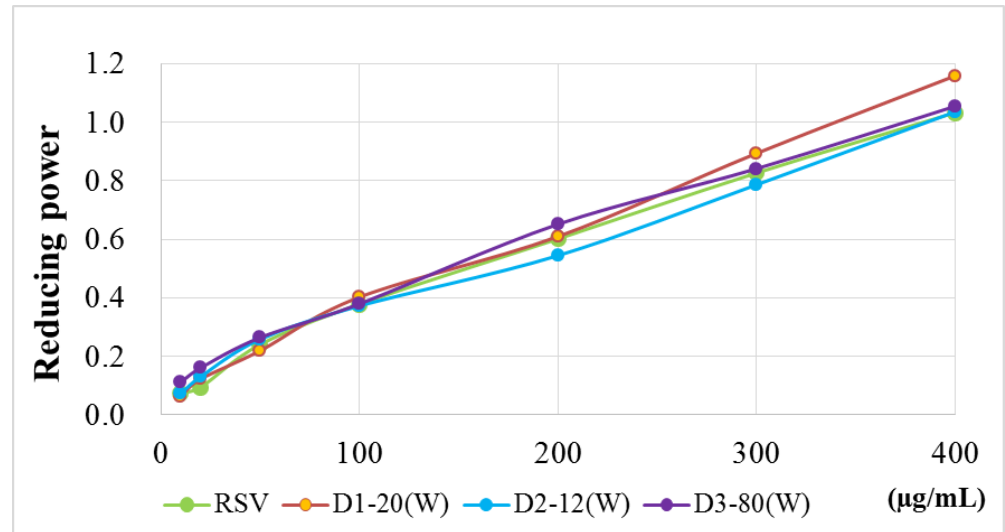
Figure 4. Reducing power of RSV and RSV transfersomes (D1–20(W), D2–12(W), and D3–80(W) groups). The ability of samples with various concentrations reduced 1% potassium ferricyanide (K 3 Fe(CN) 6 ) is presented as the reducing power.